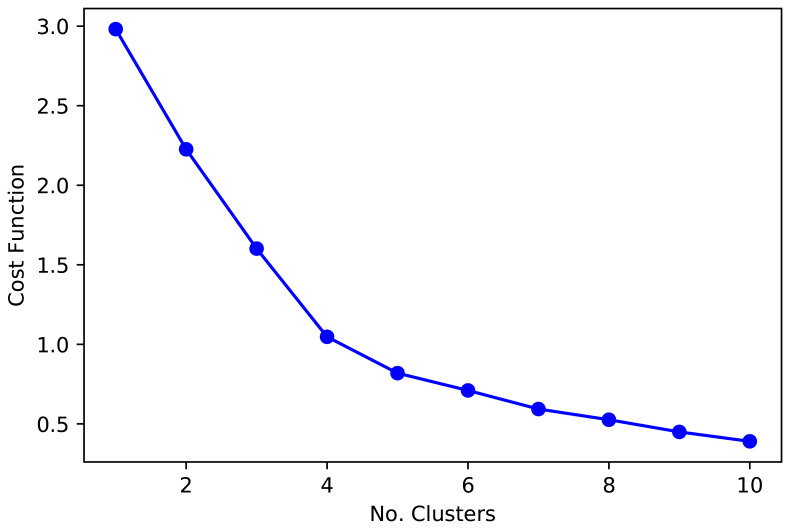
Cost function for the k-mean analysis.